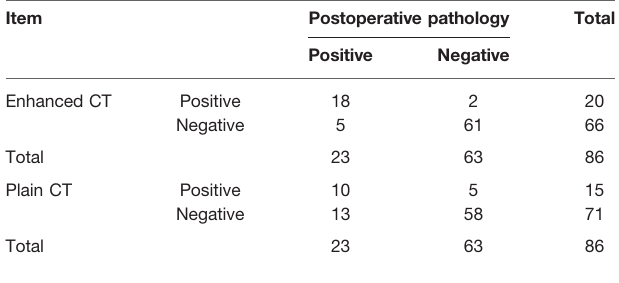
TABLE 3 | Comparison of contrast-enhanced CT and plain CT in the diagnosis of vascular tumor thrombus in lung adenocarcinoma [ n (%)].